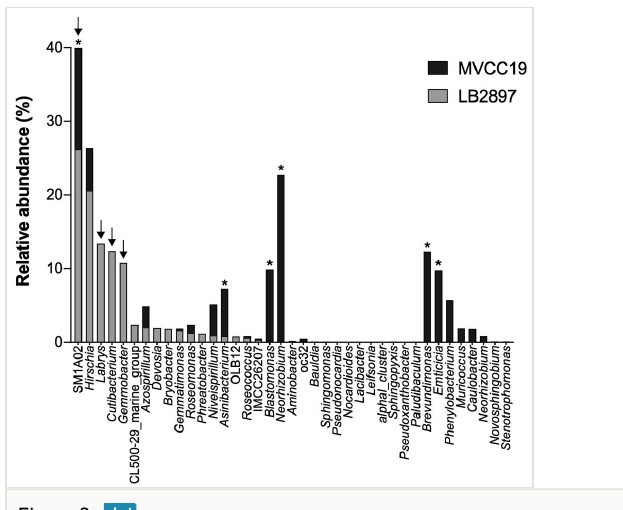
Figure 2. Abundance of the bacterial genera found in the microbiome of SxP (toxic MVCC19) and NoP (non-toxic LB2897) ecotypes of R. raciborskii . Asterisks and arrows indicate those genera accounting for more than 50% of the community in the SxP ecotype (MVCC19, black bars) and NoP ecotype (LB2897, grey bars),